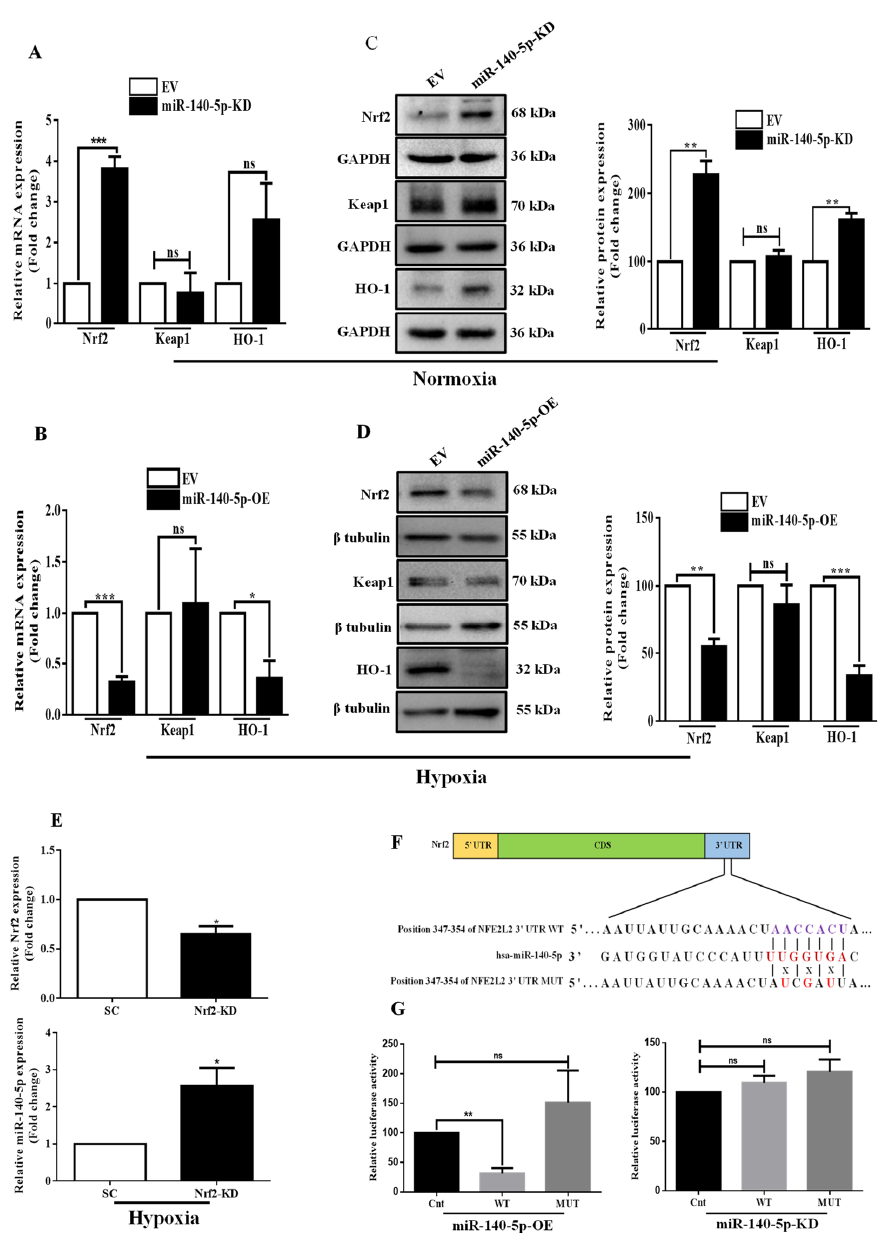
Figure 2. Nrf2 is a direct target of miR ‐ 140 ‐ 5p. ( A , B ) The mRNA and ( C , D ) protein levels of Nrf2 and its downstream genes were determined by qRT ‐ PCR and Western blotting, respectively, in MDA ‐ MB ‐ 231 cells with miR ‐ 140 ‐ 5p ‐ KD under normoxia or miR ‐ 140 ‐ 5p ‐ OE under hypoxia. Quantification of Western blot images was done by image J software. ( E ) MDA ‐ MB ‐ 231 cells with stable Nrf2 ‐ KD were subjected to hypoxia, and relative Nrf2 mRNA and miR ‐ 140 ‐ 5p levels were measured by qRT ‐ PCR. ( F ) miR ‐ 140 ‐ 5p and its complementary sites in the 3 ′‐ UTR of Nrf2 mRNA with WT and MUT sequence are shown. MUT sequence was generated by changing their complementary sites. ( G ) The luciferase assay in MDA ‐ MB ‐ 231 cells with either miR ‐ 140 ‐ 5p ‐ OE (left panel) or miR ‐ 140 ‐ 5p ‐ KD (right panel) co ‐ transfected with WT or MUT Nrf2 3 ′‐ UTR along with EFGP. EGFP (Renilla luciferase) was used for the normalization of fluorescence intensity. Error bars indicate mean ± SEM ( n = 3). Student’s t ‐ tests were used to compare the means of two groups. ns: not significant , * p < 0.05, ** p < 0.01, and *** p < 0.001 compared to EV.